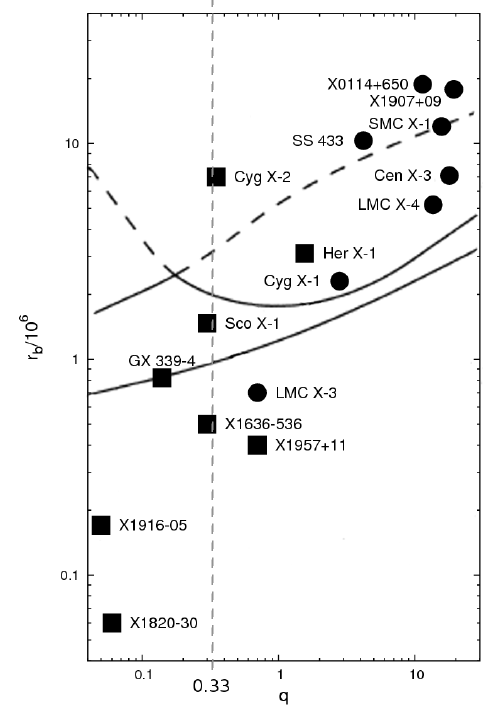
Figure 1: Accretion disc stability to radiation-driven warping in XRBs, as functions of q and r b ( adapted from Ogilvie & Dubus (2001) to include only XRBs with known super-orbital periods and updated with their latest system parameters (See Table 1).